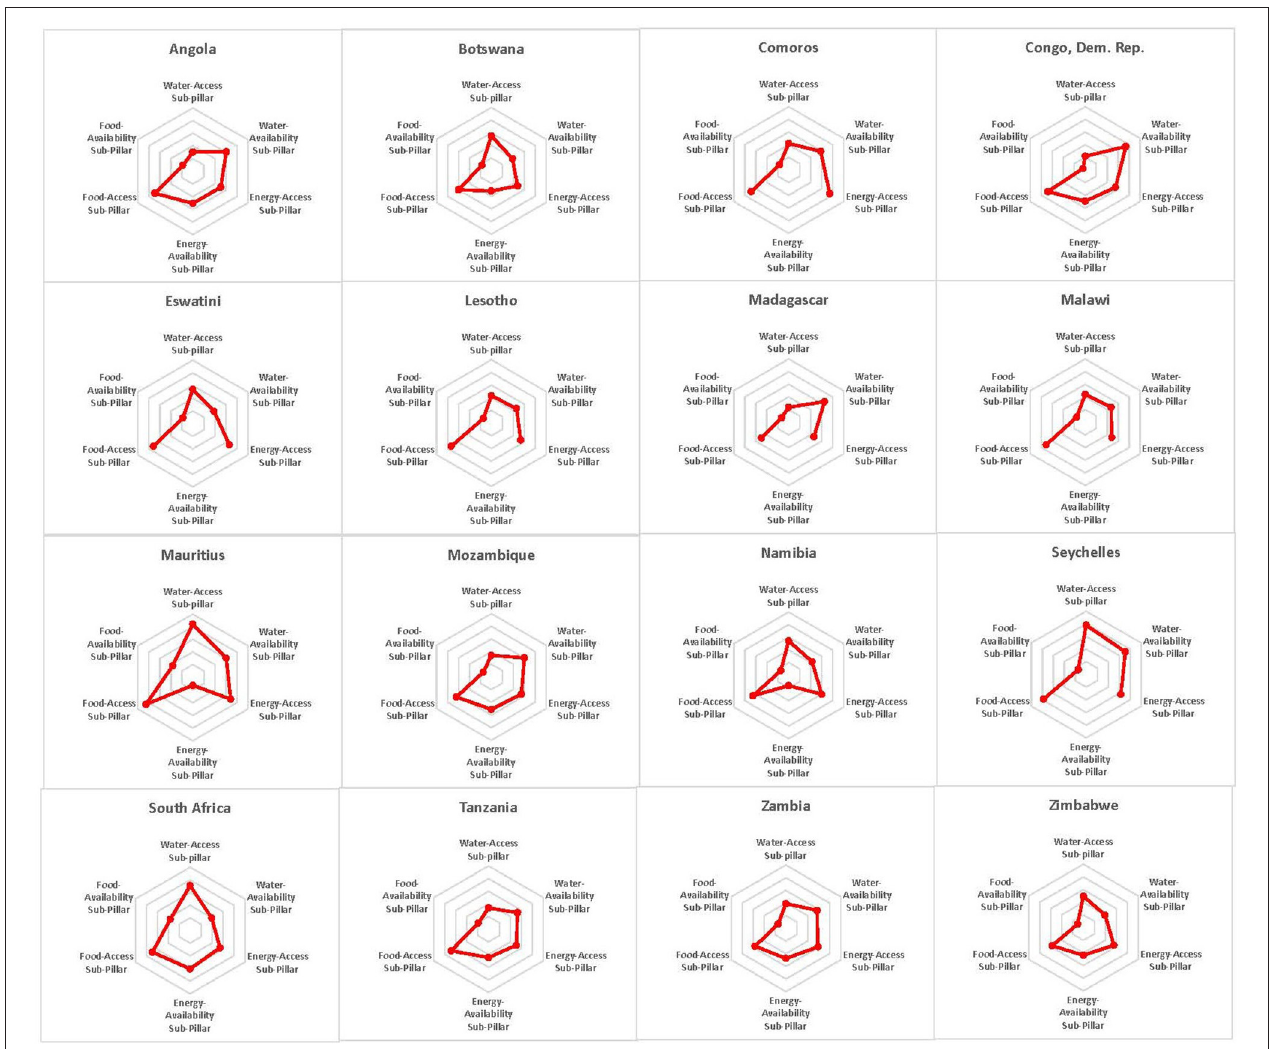
FIGURE 8 | Radar graphs of the sub-pillars for the 16 SADC